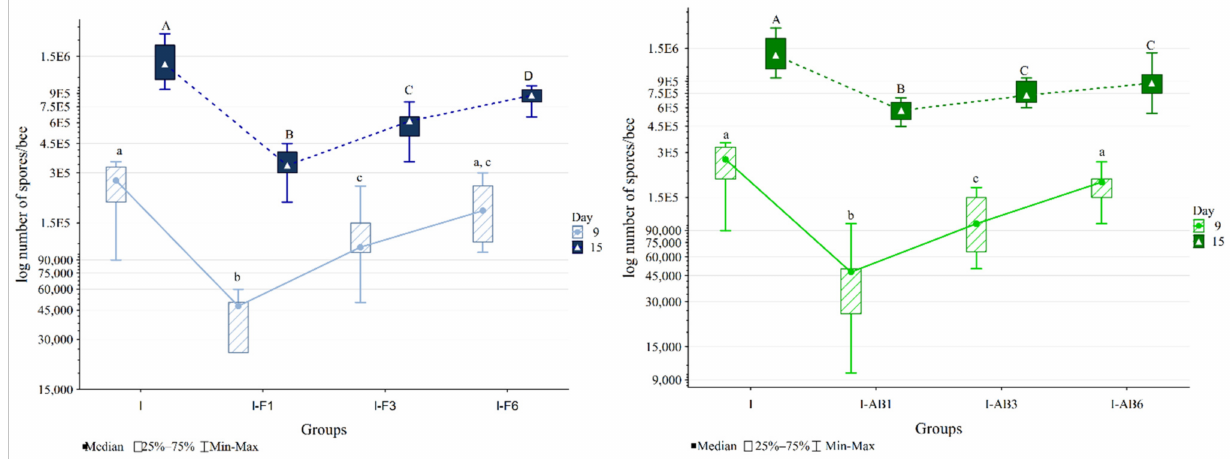
Figure 3. Nosema spore loads in infected control (I) and groups infected and treated with fumagillin from day 1 (I-F1), day 3 (I-F3) and day 6 (I-F6) or A. blazei extract from day 1 (I-AB1), day 3 (I-AB3) and day 6 (I-AB6). Group names are indicated in Table 1. Groups labelled with the same letter did not differ significantly. The same font size (lowercase or uppercase) refers to the same time